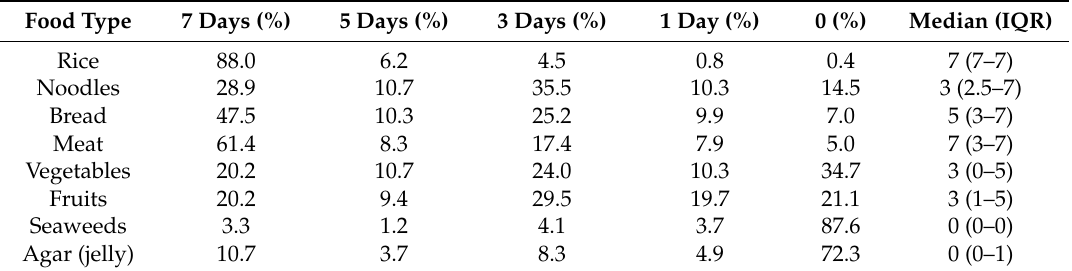
Table 3. Result of diet questionnaire survey: average days in a week foods were